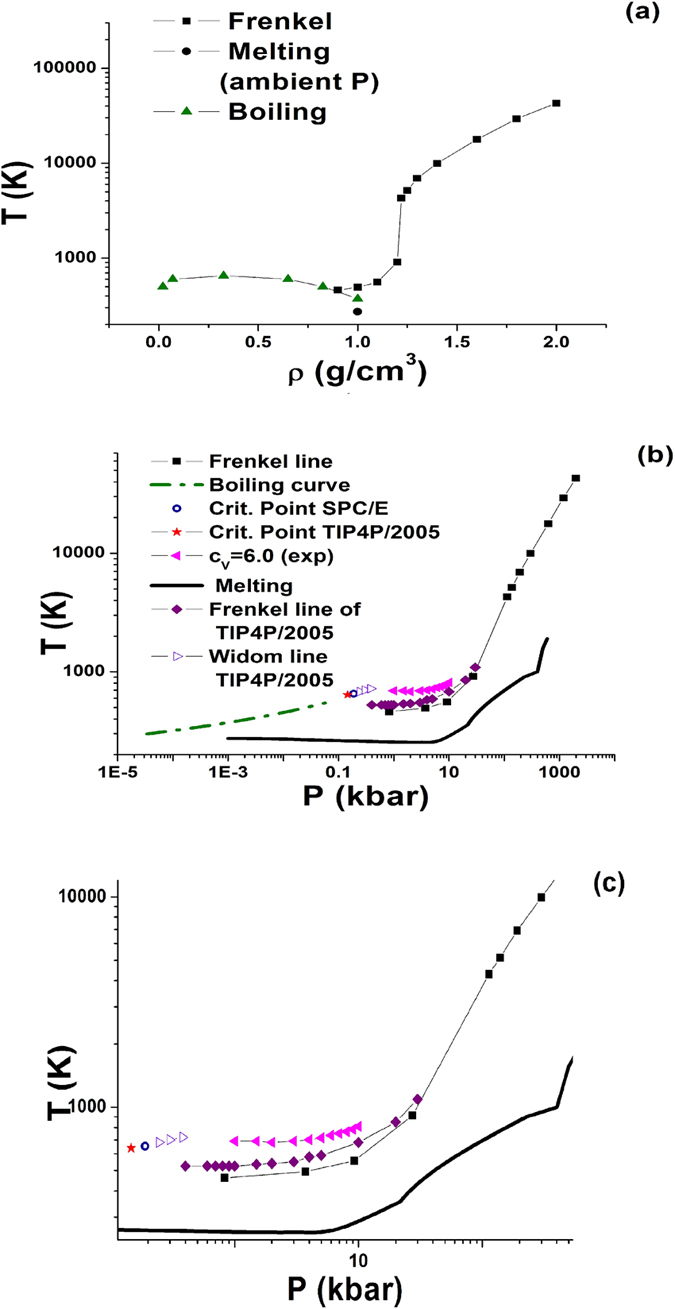
Location of Frenkel line of water in the phase diagram in (a) ρ − T and (b) P − T coordinates.The Frenkel line is obtained from vacf criterion. In case of P − T diagram the boiling curve corresponds to the experimental curve36, the critical point is taken for SPC/E model33. The melting line is combined from several publications24373839404142. Experimental data for heat capacity are taken from NIST database23. The Frenkel line of TIP4P/2005 water is taken from ref. 13. Widom line of TIP4P/2005 model is taken from ref. 21. Panel (c) enlarges the moderate pressure part of the diagram. The notation of this panel is the same that in panel (b).